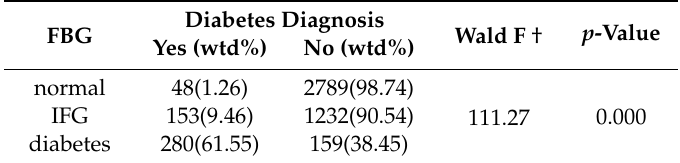
Table 2. Fasting blood glucose (FBG) and diabetes diagnosis by